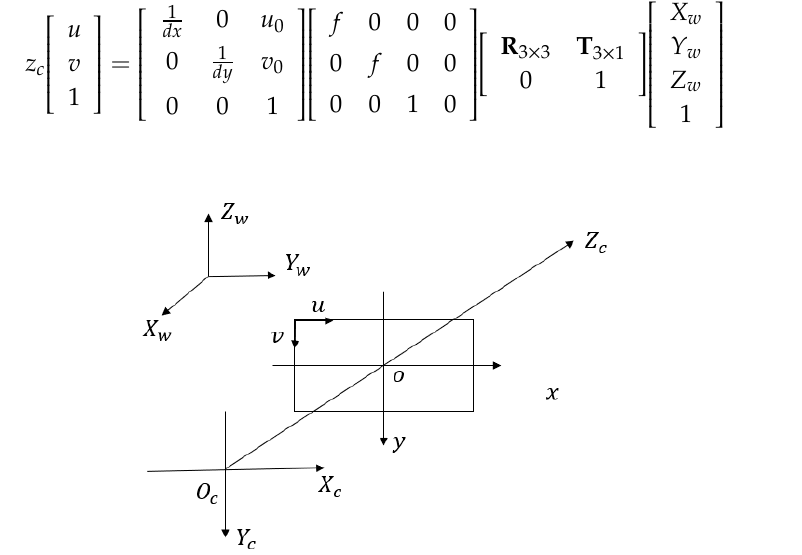
Figure 2. Relationship between coordinate systems.